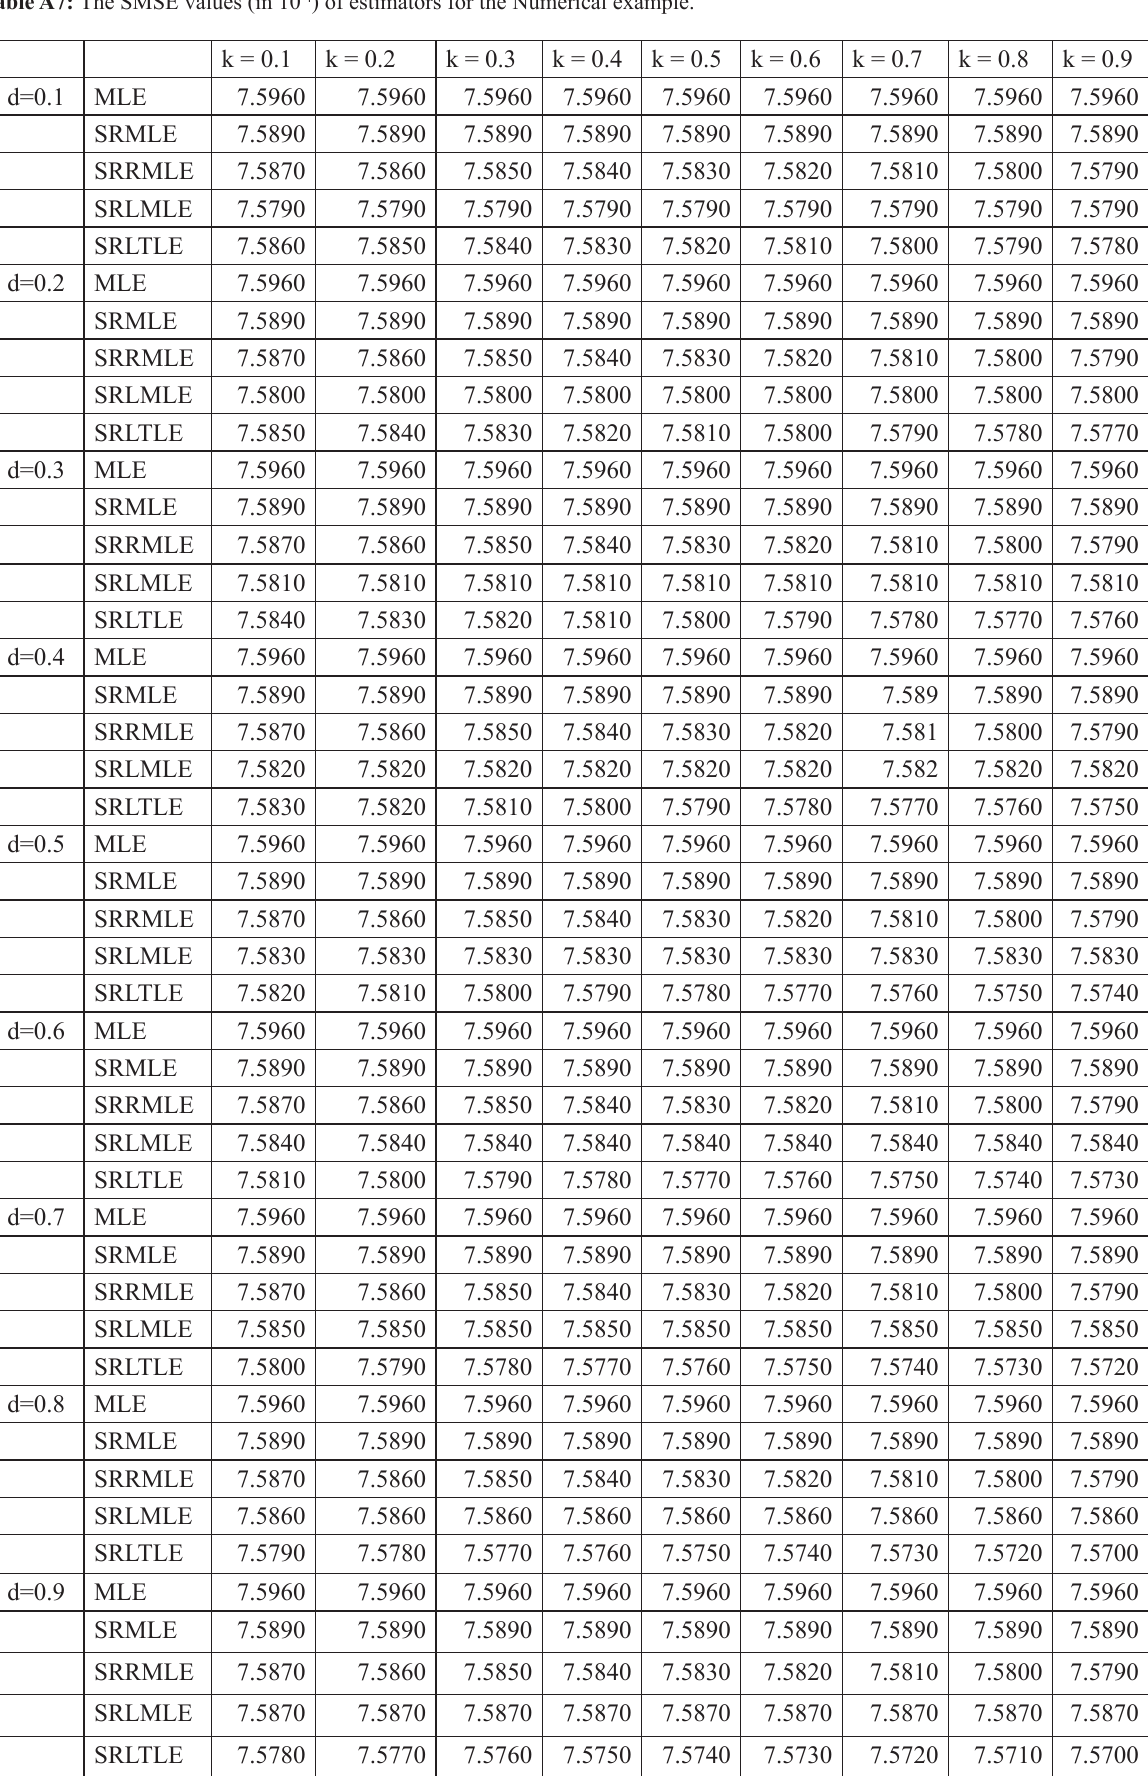
Table A7: The SMSE values (in 10 -4 ) of estimators for the Numerical example. k = 0.1 k =